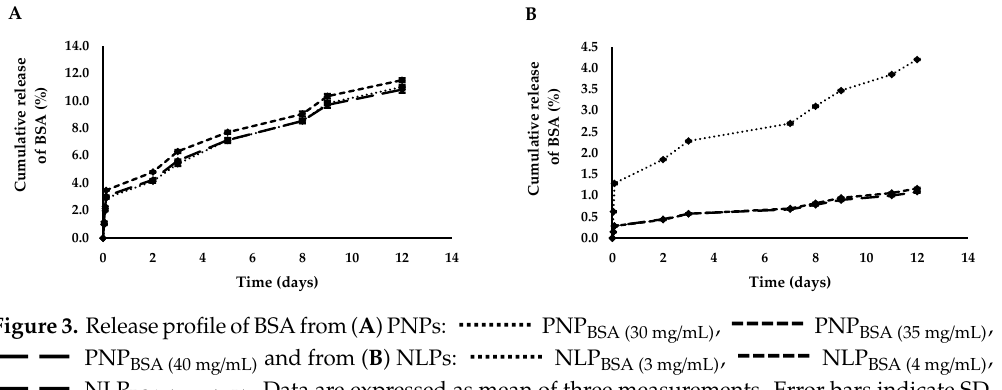
Figure 3. Release profile of BSA from ( A ) PNPs: PNP BSA (30 mg/mL) , PNP BSA (35 mg/mL) , PNP BSA (40 mg/mL) and from ( B ) NLPs: NLP BSA (3 mg/mL) , NLP BSA (4 mg/mL) , NLP BSA (6 mg/mL) . Data are expressed as mean of three measurements. Error bars indicate SD. BSA: bovine serum albumin, PNPs: polymeric nanoparticles, NLPs: nanoliposomes.